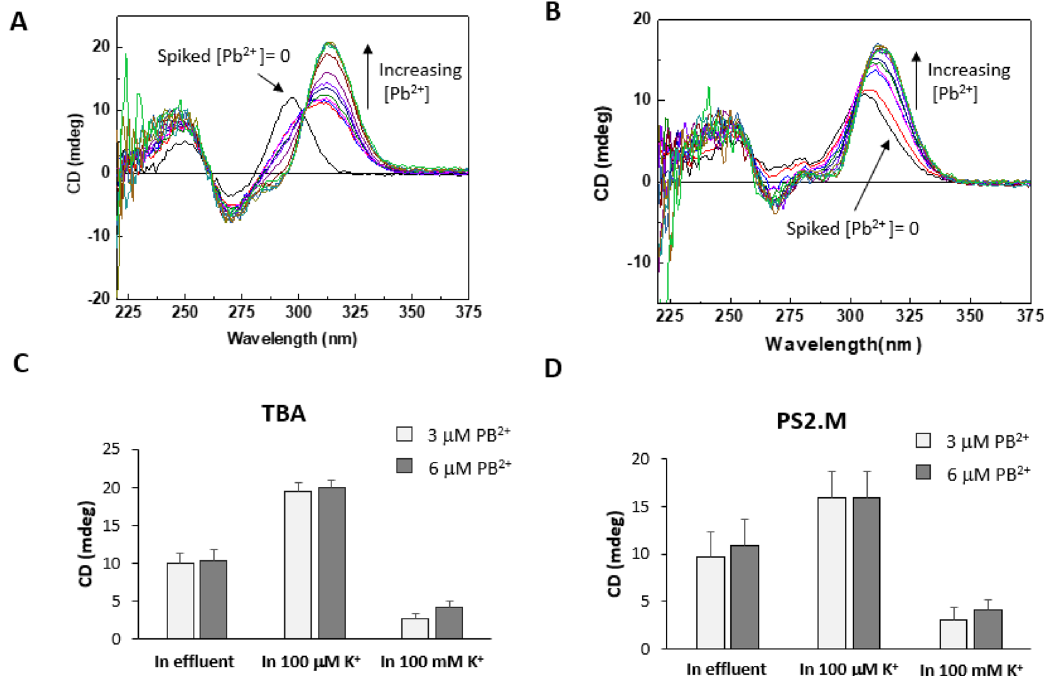
Figure 8. CD spectra of Pb 2+ -spiked effluent samples discharged from a local wastewater treatment plant (WWTP). Pb 2+ detection using TBA ( A ) and PS2.M ( B ). Comparison of CD spectra of TBA ( C ) and PS2.M ( D ) added by Pb 2+ -spiked effluent samples and Pb 2+ in 100 μM and 100 mM K + solution.